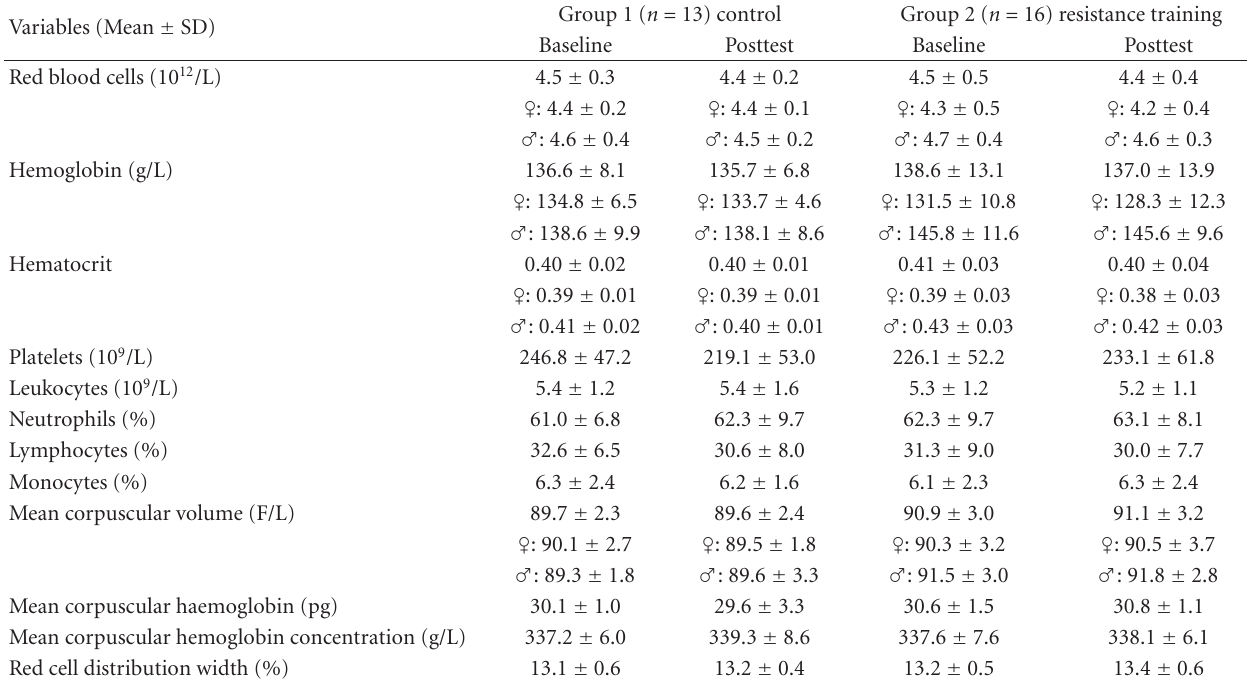
Table 2: Hematological parameters of subjects by groups before and after